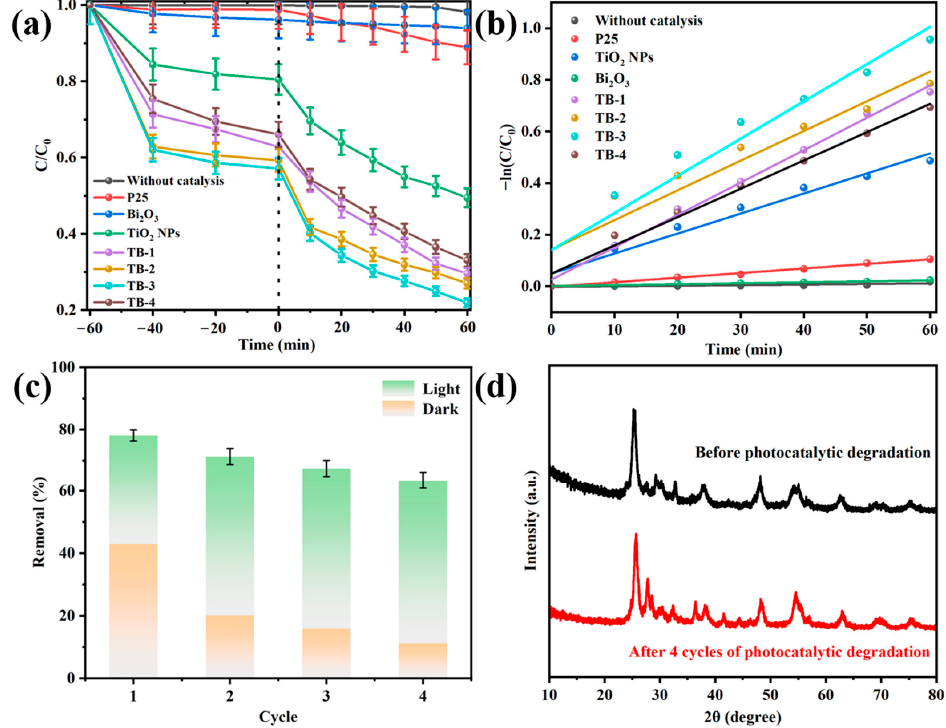
Figure 8. ( a ) Adsorption in the dark and photocatalytic degradation of TC under visible light irradiation by using the as-prepared samples and P25. ( b ) The fitting of the pseudo-first-order kinetic model. ( c ) Cyclic adsorption–photocatalytic degradation of TC over TB-3. ( d ) XRD patterns of TB-3 before and after four cycles.